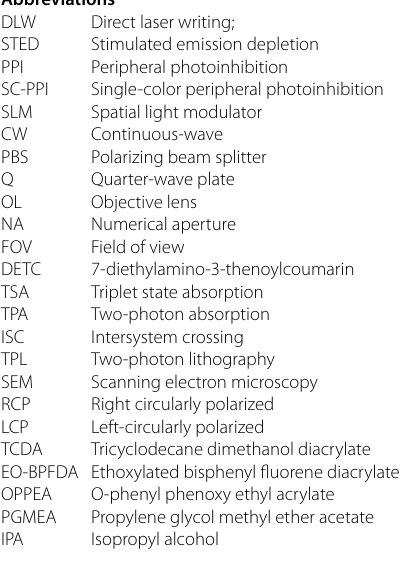
equipped with a Nikon Intensilight Epi-fluorescence illuminator and a Nikon DS-Ri1